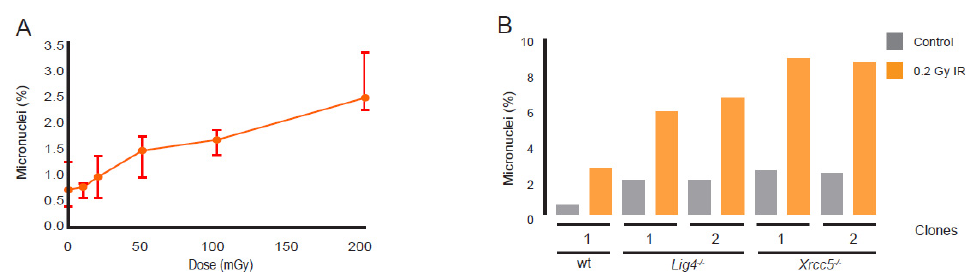
Figure 6. Micronuclei frequency in DSB repair-proficient and -deficient mESCs. ( A ) Induction of micronuclei (in % of micronuclei among bi-nucleated cells) as a measure of genetic damage in repair-proficient cells in response to increasing doses of IR. Dots and error bars represent median and 95% CI values, respectively. ( B ) MN frequency in wt, Lig4 -/- and Xrcc5 -/- cells in response to IR (0.2 Gy).